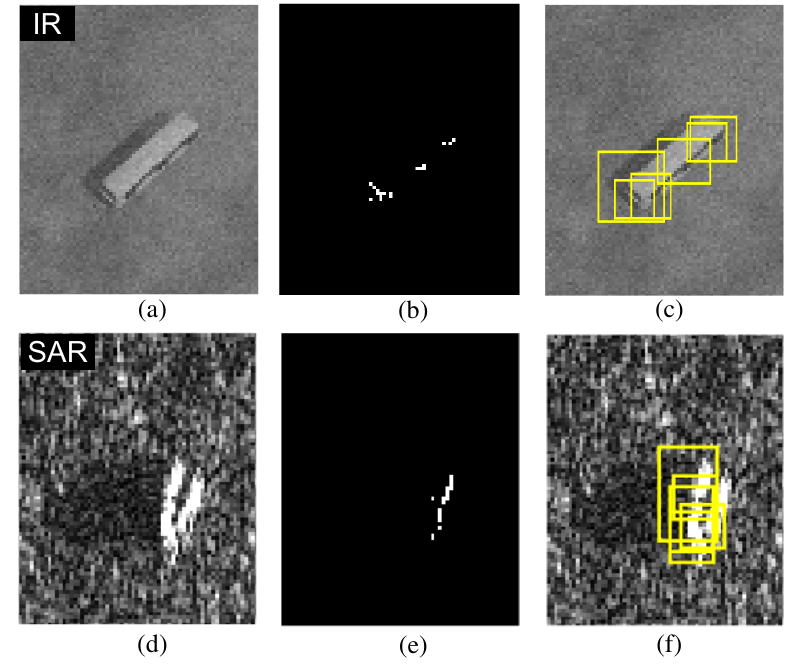
Figure 10. Problems of the original BMVT-based extended target detection: ( a ) extended IR target image; ( b ) IR target extracted map by applying a threshold to the enhanced map; ( c ) 8-nearest neighbor-based final IR target detection results; ( d ) extended SAR target image; ( e ) SAR target extracted map; ( f ) final SAR target detection